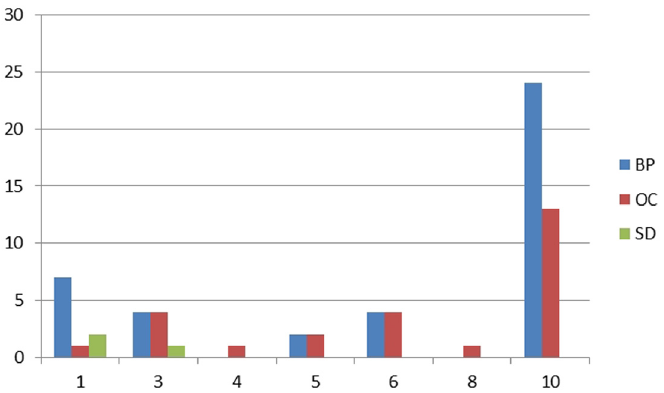
Figure 5: Racot 18. Frequency of fracture types for cattle, sheep/goat, and pigs from loam pits, phase IIA. ( 1: stepped; 2: jagged; 3: perpendicular irregular; 4: oblique irregular; 5: perpendicular regular; 6: oblique regular; 7: spiral irregular; 8: spiral regular; 9: channelled; 10: longitudinal. Note: categories 2, 7, and 9 are not represented in this fi gure ) ( after Marciniak, 2014a, Figure 9.6. )